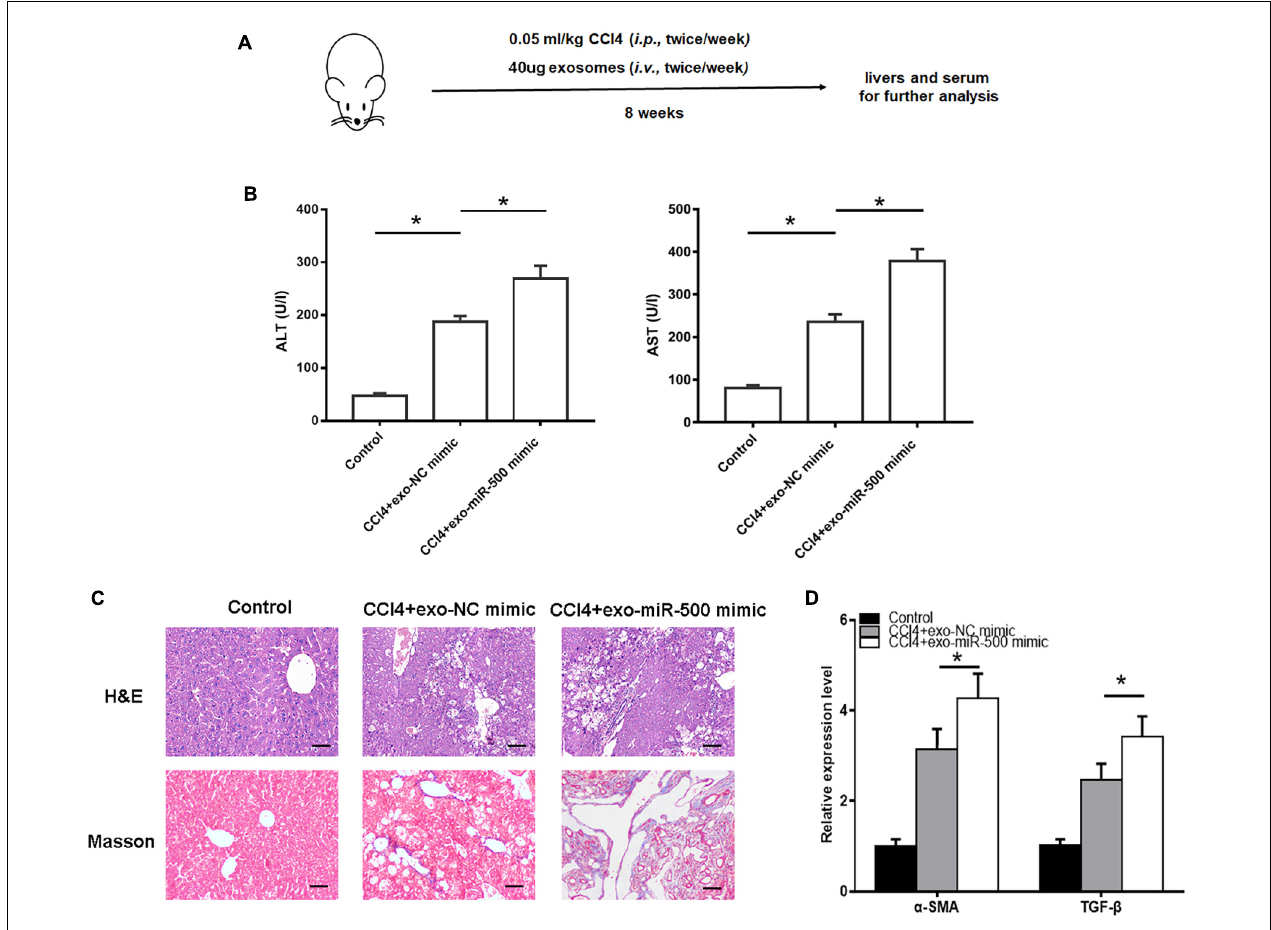
FIGURE 4 | Exosomal miR-500 accelerates liver fibrosis in vivo . (A) The strategy for CCl 4 –induced liver fibrosis in vivo . (B) ALT and AST levels in mouse serum isolated from Control, CCl 4 +exo-NC mimic and CCl 4 +exo-miR-500 mimic groups were determined. Mean ± SD. n = 8. (C) H&E and Masson staining of mouse liver from Control, CCl 4 +exo-NC mimic and CCl 4 +exo-miR-500 mimic groups (magnification 100 × ). (D) The mRNA levels of α -SMA and TGF- β in liver tissues of different groups were assessed by qRT–PCR. * P <